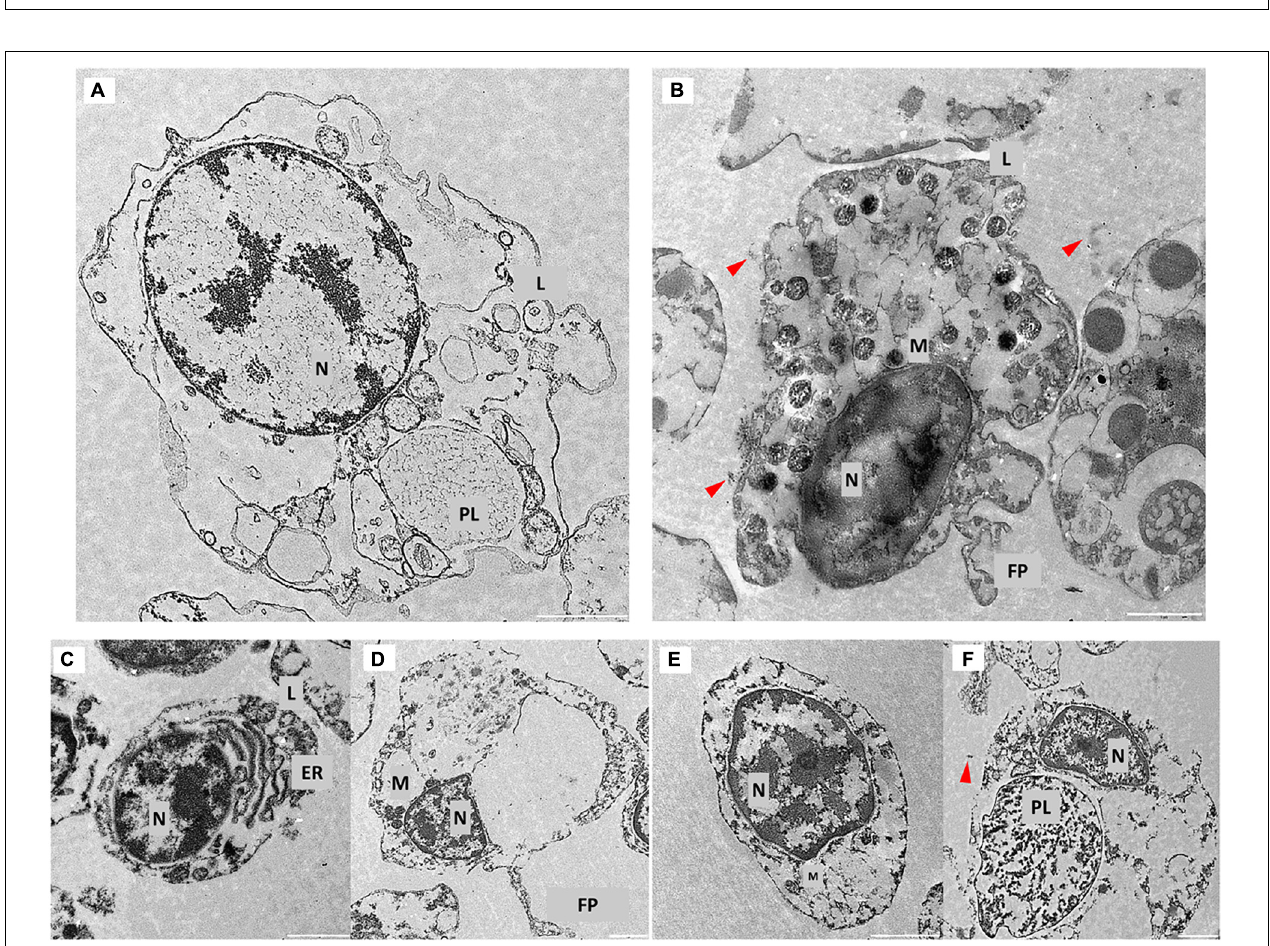
FIGURE 9 | TEM analysis of phagocytes. Representative TEM images of control phagocytes (A,C,D) and after exposure to PS-COOH at 25 µ g mL − 1 (B,E,F) . Foreign material around cell surface and membrane damage is shown (red arrows). N, nucleus; M, mitochondria; PL, phago-lysosome; L, lysosome; FP, filopodia; ER, endoplasmic reticulum. TEM images were recorded using a LEO 912AB microscope. Scale bars: 1 µ m.